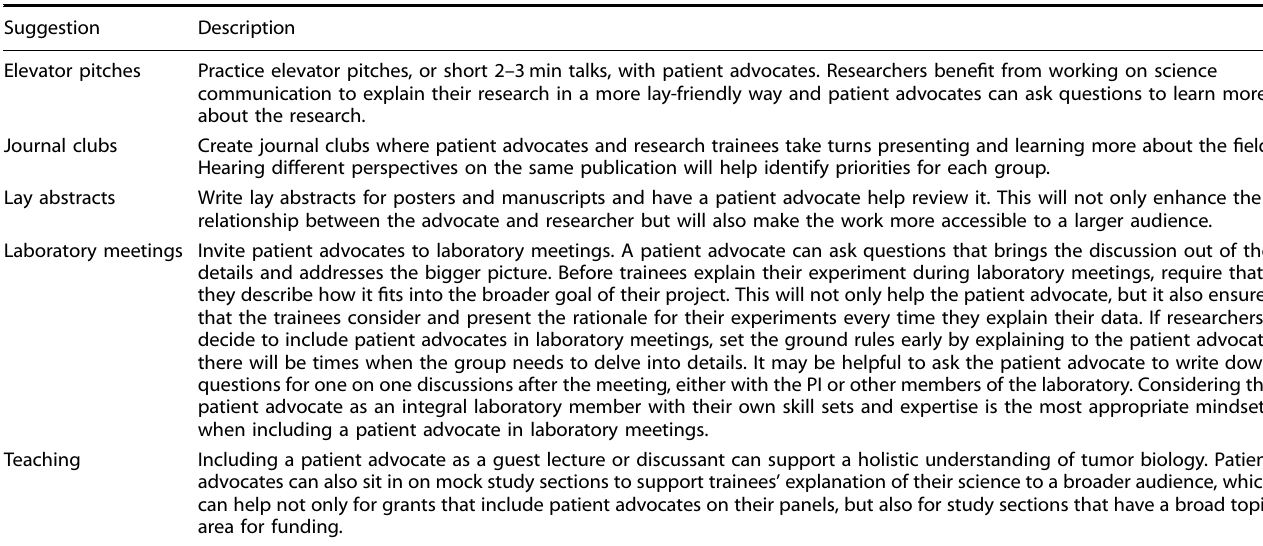
Table 2. Opportunities for